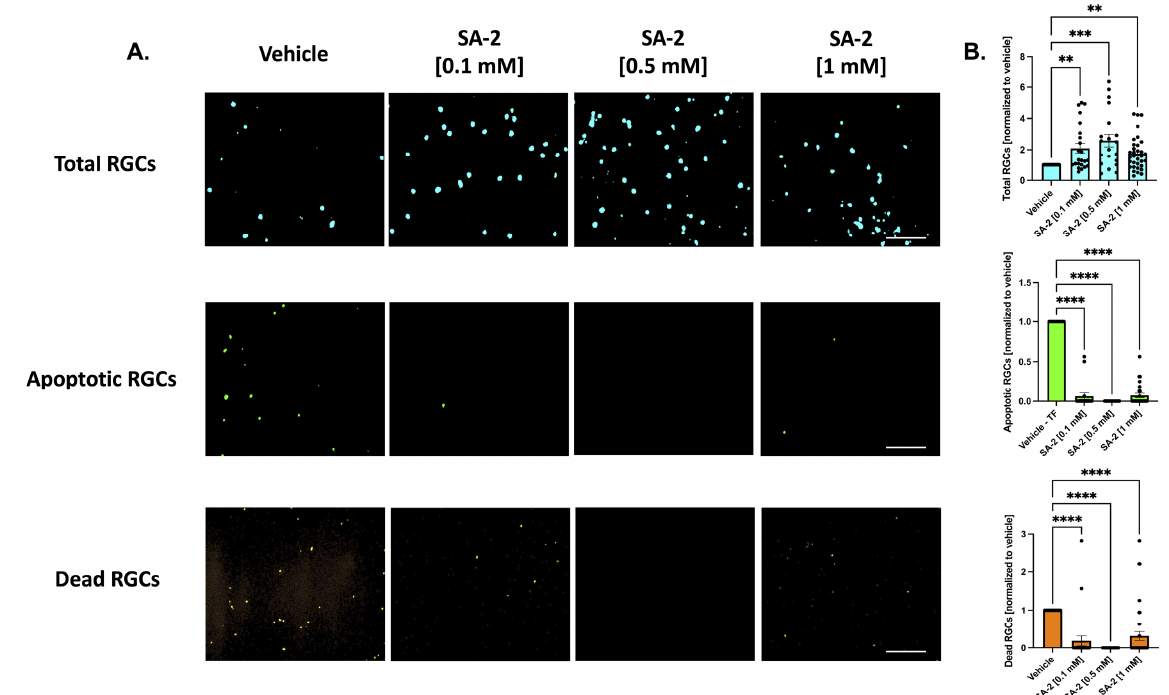
Figure 2. Treatment of primary retinal ganglion cells (RGCs) from Sprague Dawley rat pups in the absence of neurotrophic factors. ( A ) Representative images of RGCs treated with either vehicle (Dulbecco’s phosphate-buffered saline/DPBS) or SA-2 in the absence of neurotrophic factors for 48 h; ( B ) Graph bars represent total (blue, Hoechst 33342), apoptotic (green, active caspase-3 and caspase-7), and dead (orange, propidium iodide) RGC counts as a ratio to the total cells in the vehicle control group. In the absence of neurotrophic factors, SA-2 mediated a significant decrease in apoptotic cells by 92.78% ( p < 0.0001) and a 68.57% ( p < 0.0001) decrease in dead cells, using Kruskal–Wallis followed by Dunn’s multiple comparisons. Data represent the mean ± standard error of the mean (SEM) (n = 3 biological replicates). ** p < 0.01, *** p < 0.001, **** p < 0.0001. The scale bar represents 200 µ